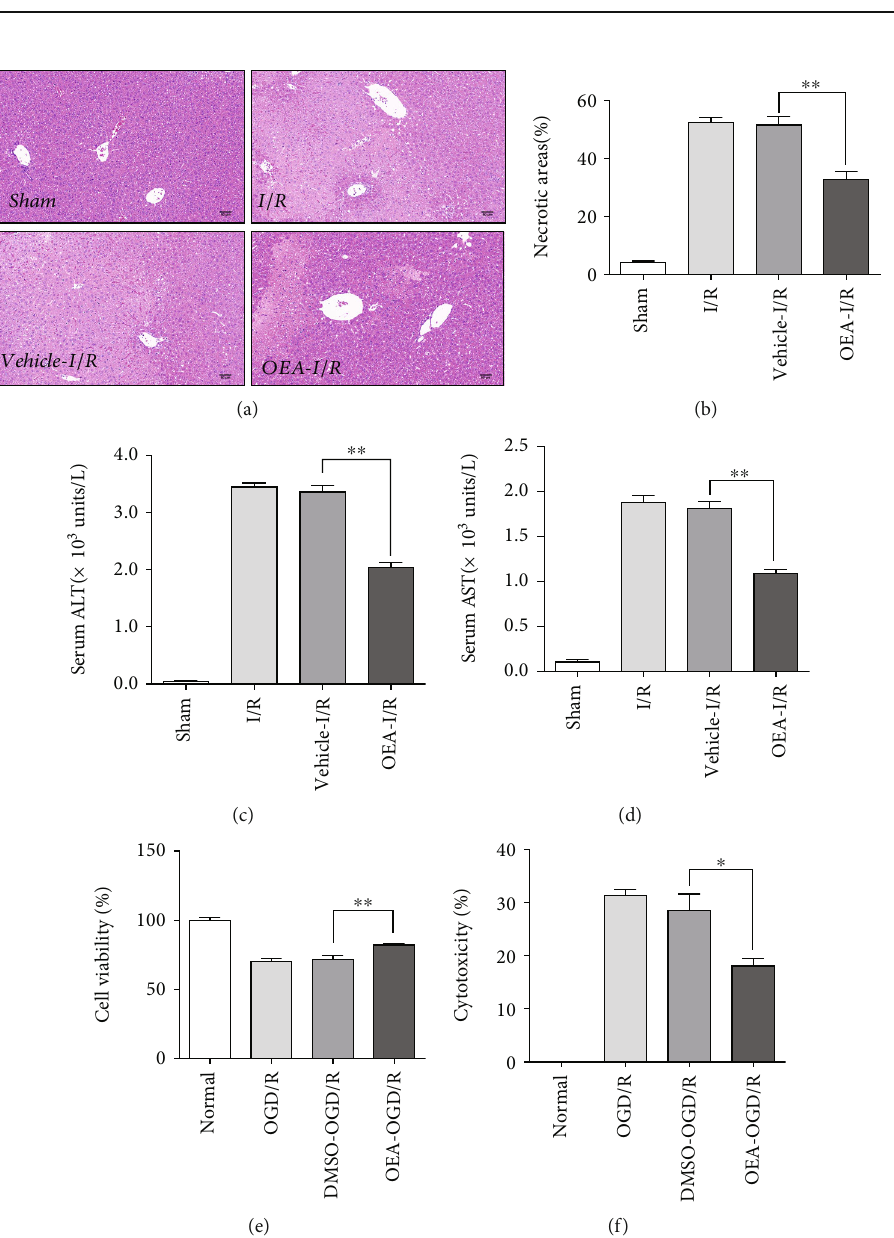
Figure 1: OEA treatment protects liver I/R injury. OEA treatment in mice was conducted by intraperitoneal (20 mg/kg) for 1h before ischemia. The liver tissue and serum were harvested after reperfusion 6h. OEA treatment of HepG2 cells (20 μ M) was conducted for 1 h before OGD/R. (a) Representative HE-stained images after reperfusion 6 h or sham group. (b) Percentage of necrotic areas. (c and d) The level of serum ALT and AST. (e and f) Cell viability and cytotoxicity of HepG2 cells after OGD/R with OEA or DMSO treatment were measured. ∗∗ p < 0 : 01 and ∗ p < 0 : 05